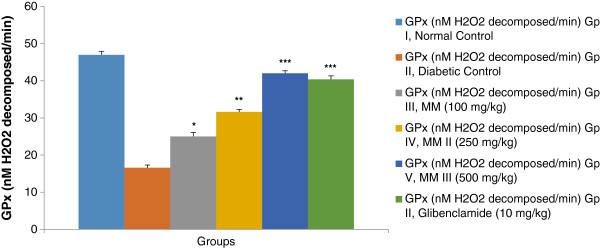
Effect of Melastoma malabathricum Linn. (MM) on level of Glutathione peroxidase (GPx) at different concentrations on STZ induced diabetic rats, compared to standard drug Glibenclamide; values are mean ± SEM; n = 6; *P < 0.05; **P < 0.01; ***P < 0.001; P > 0.05 is considered as non-significant (ns).